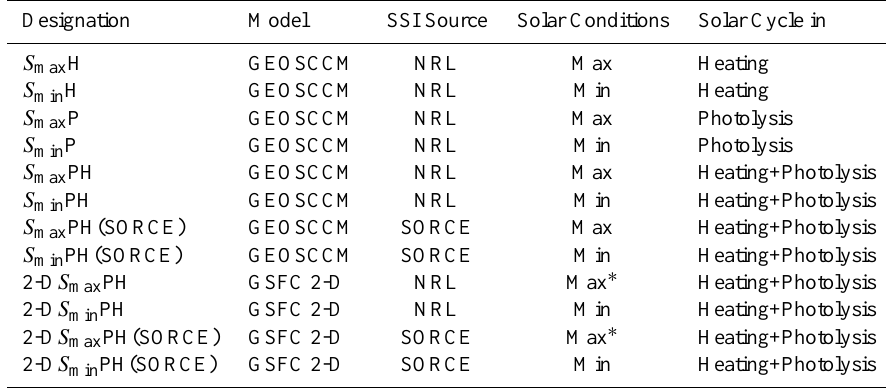
Table 1. List of CCM time-slice simulations performed with the GEOSCCM and GSFC 2-D model. Designation Model SSI Source Solar Conditions Solar Cycle in S max H GEOSCCM NRL Max Heating S min H GEOSCCM NRL Min Heating S max P GEOSCCM NRL Max Photolysis S min P GEOSCCM NRL Min Photolysis S max PH GEOSCCM NRL Max Heating+Photolysis S min PH GEOSCCM NRL Min Heating+Photolysis S max PH(SORCE) GEOSCCM SORCE Max Heating+Photolysis S min PH(SORCE) GEOSCCM SORCE Min Heating+Photolysis 2-D S max PH GSFC 2-D NRL 2-D S min